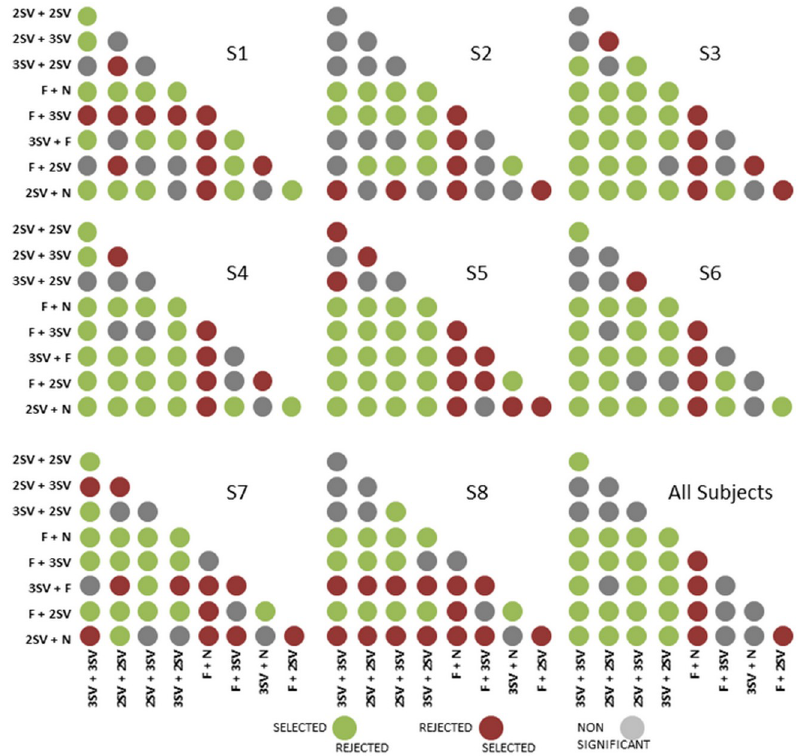
Fig 5. Preference maps for pair-wise comparison of binocular simultaneous vision, monovision and modified monovision corrections for all subjects (S1 to S8) and pooled across subjects.